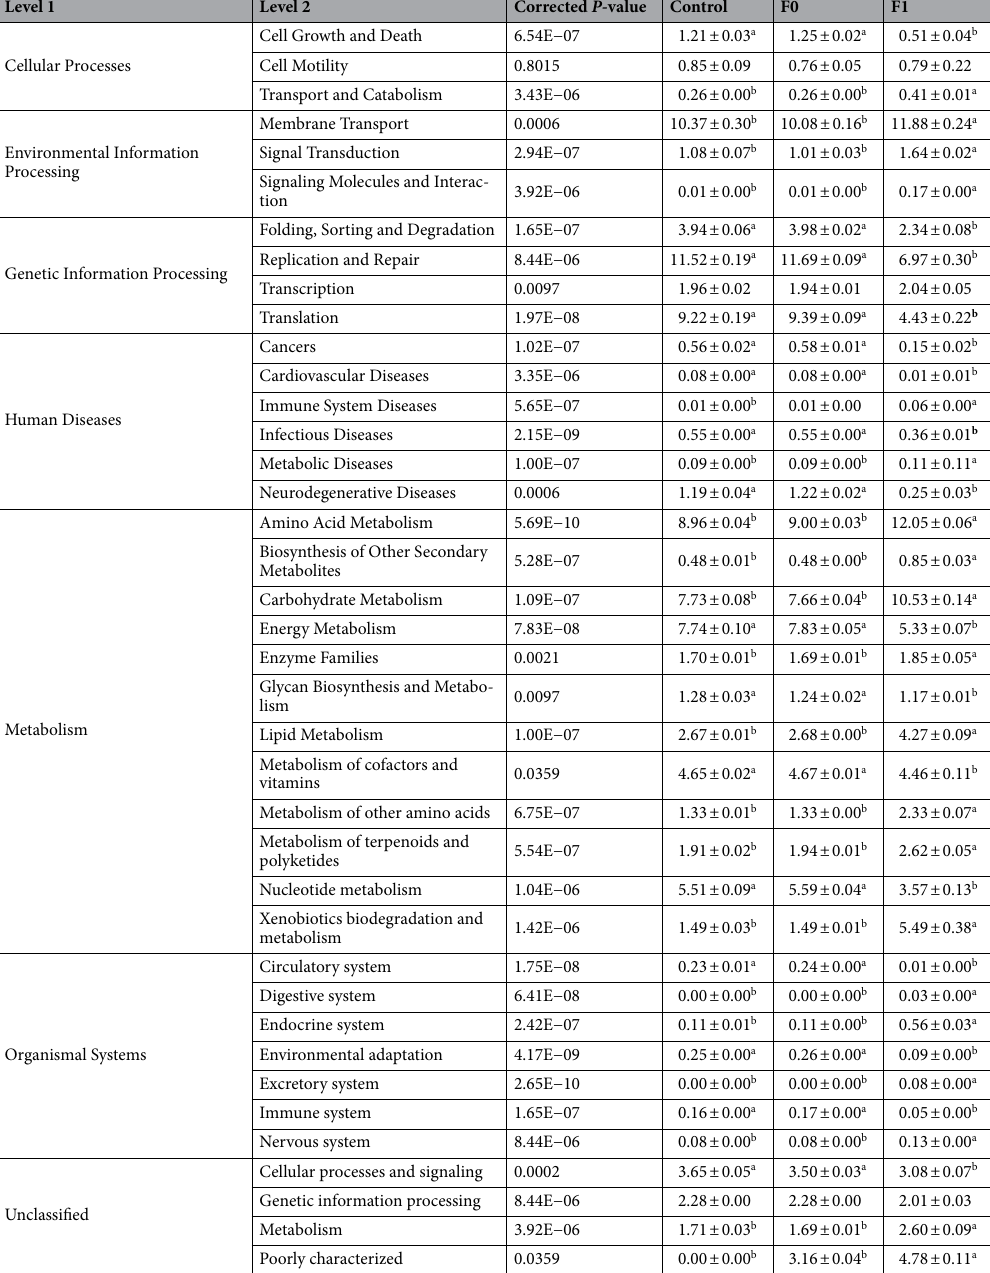
Table 4. Mean relative abundance of the predicted functions of the bacterial communities grouped according to KEGG pathway categories among the three study groups. Different letters in the same row indicate